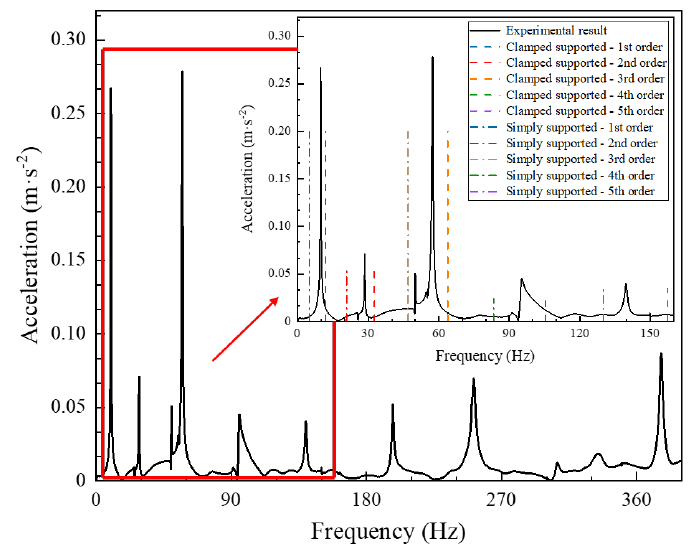
Figure 5. The natural frequency of the single-span